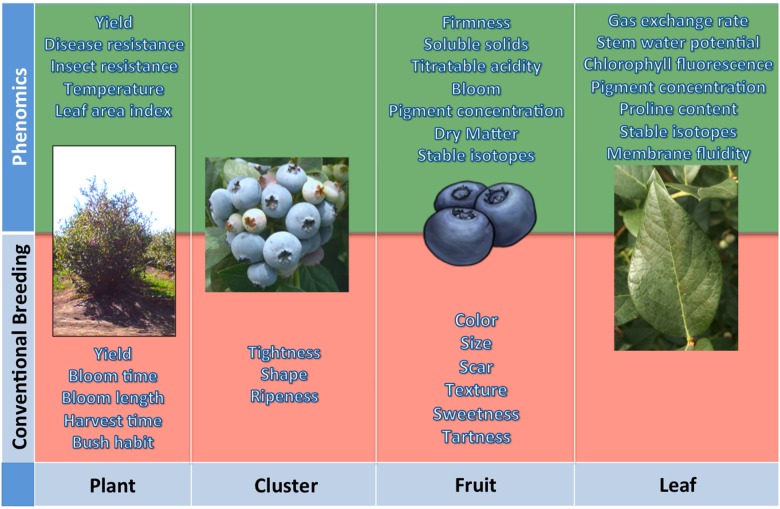
The traits commonly evaluated by a plant breeder are highlighted in red. Others that can be estimated by phenomics are highlighted in green—mostly of these are valuable morpho-physiological and physico-chemical traits that most breeders are not able to consider.